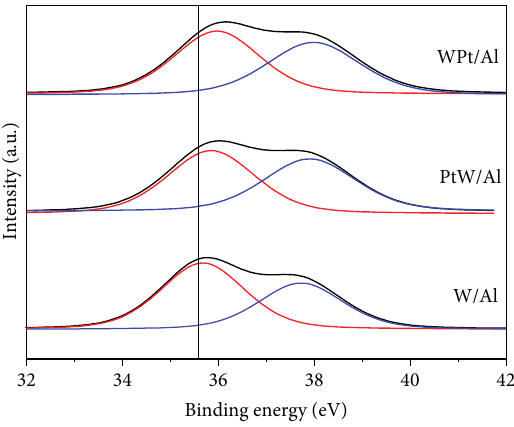
region. PtW/AlWPt/Al 7/2 F 4: Styrene total conversion as a function of time in the absence of poison.